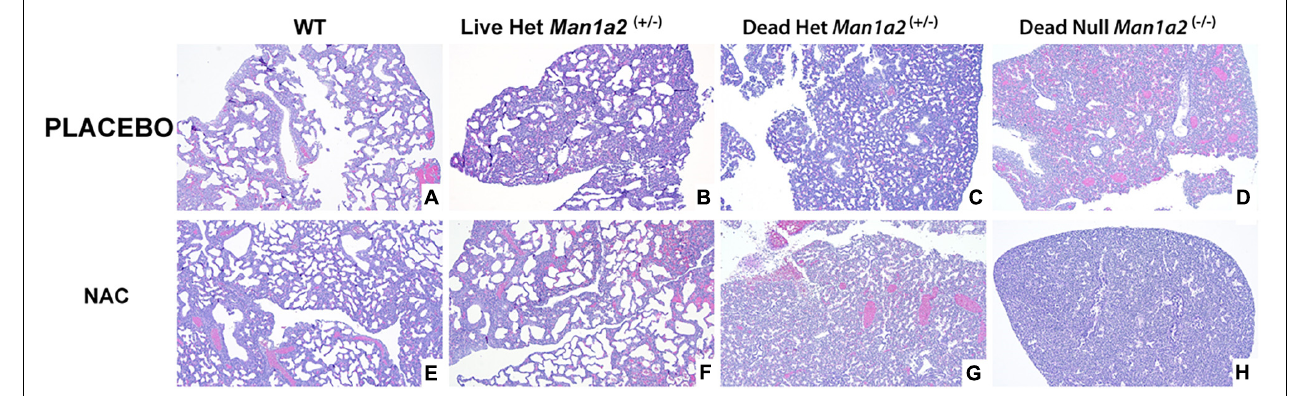
FIGURE 3 | Lung morphology showing striking differences in alveolar development in mice treated with placebo (upper row A–D ) or NAC (Lower row E–H ). (A) Wild type-placebo; (B) Heterozygous, live-placebo; (C) Heterozygous, dead-placebo; (D) Null, dead-placebo; (E) Wild type-NAC; (F) Heterozygous, live-NAC; (G) Heterozygous, dead-NAC; (H) Null, dead-NAC Upper row shows animals treated with placebo. There is a progressive arrest in alveolar development WT to dead null pups. NAC treatment (lower row) has a similar progressive arrest in alveolar development. However, live NAC-treated heterozygous pups show higher counts and size of alveoli similar to NAC-treated WT pups. WT, Wild type; Het, Heterozygous Man1a2 ( + / − ) ; Null, Man1a2 ( − / − ) .